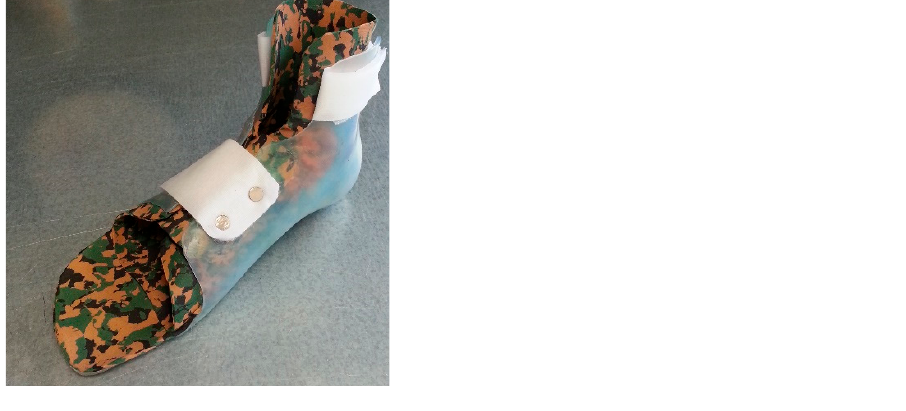
Figure 4. The design of DAFO 4 with a posterior strap (for flexible control of foot position and alignment, allows full plantar flexion and dorsiflexion).